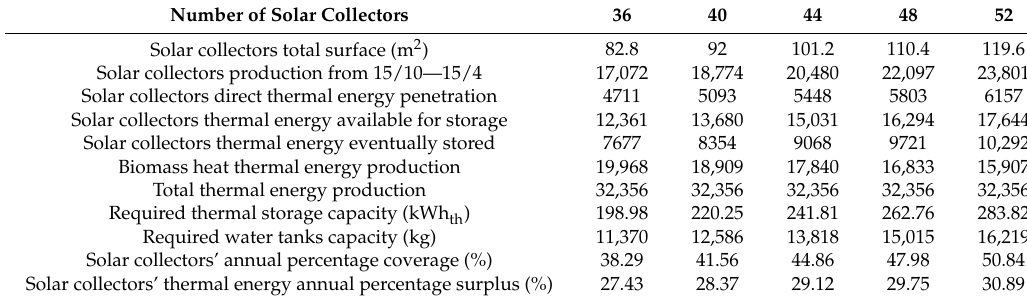
Table 4. Annual thermal energy production and storage results.